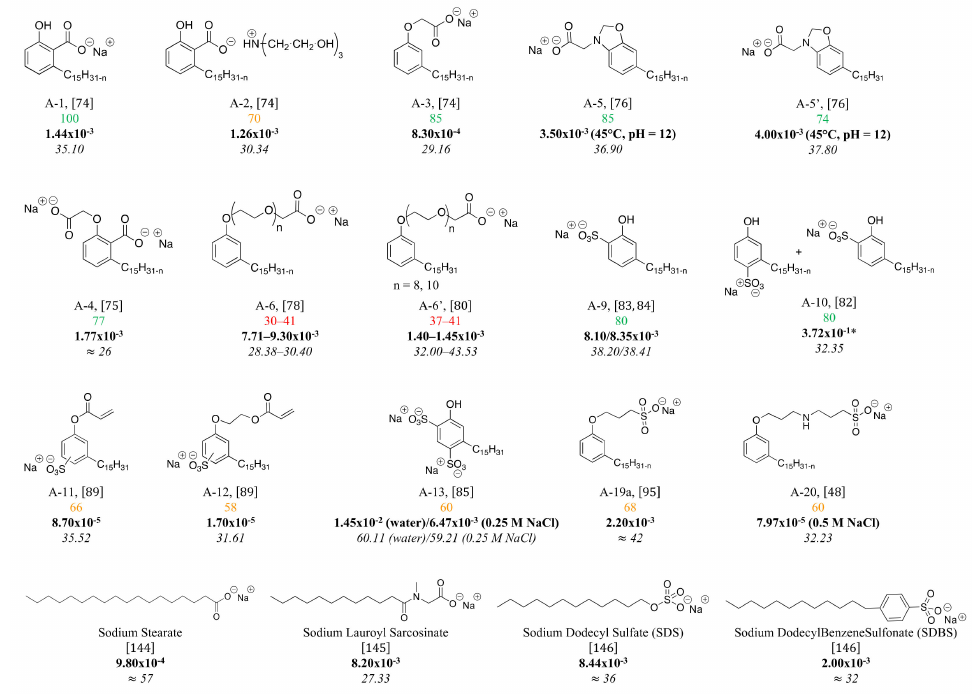
Figure 10. % bio (green for % up to 75%, red for % under 50% and orange in between (50–75%), CMC (mol/L, bold) and surface tension (mN/m, italics) of anionic CNSL-based